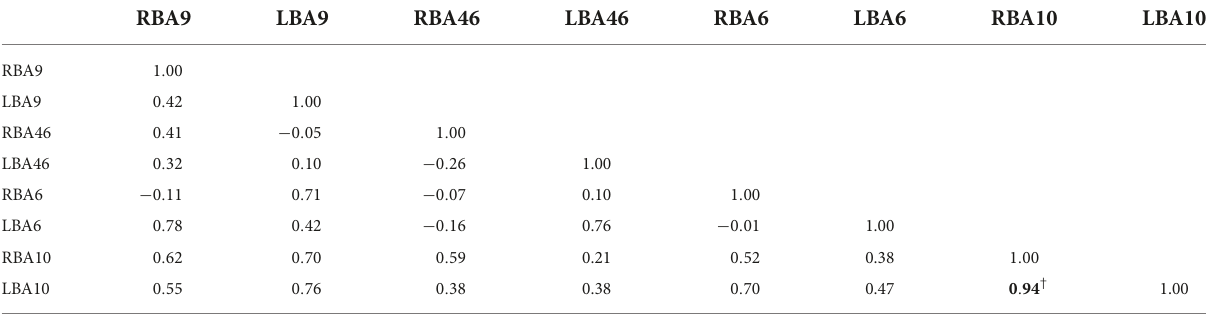
TABLE 8 HbR-based ROIs connectivity analysis—the control group.